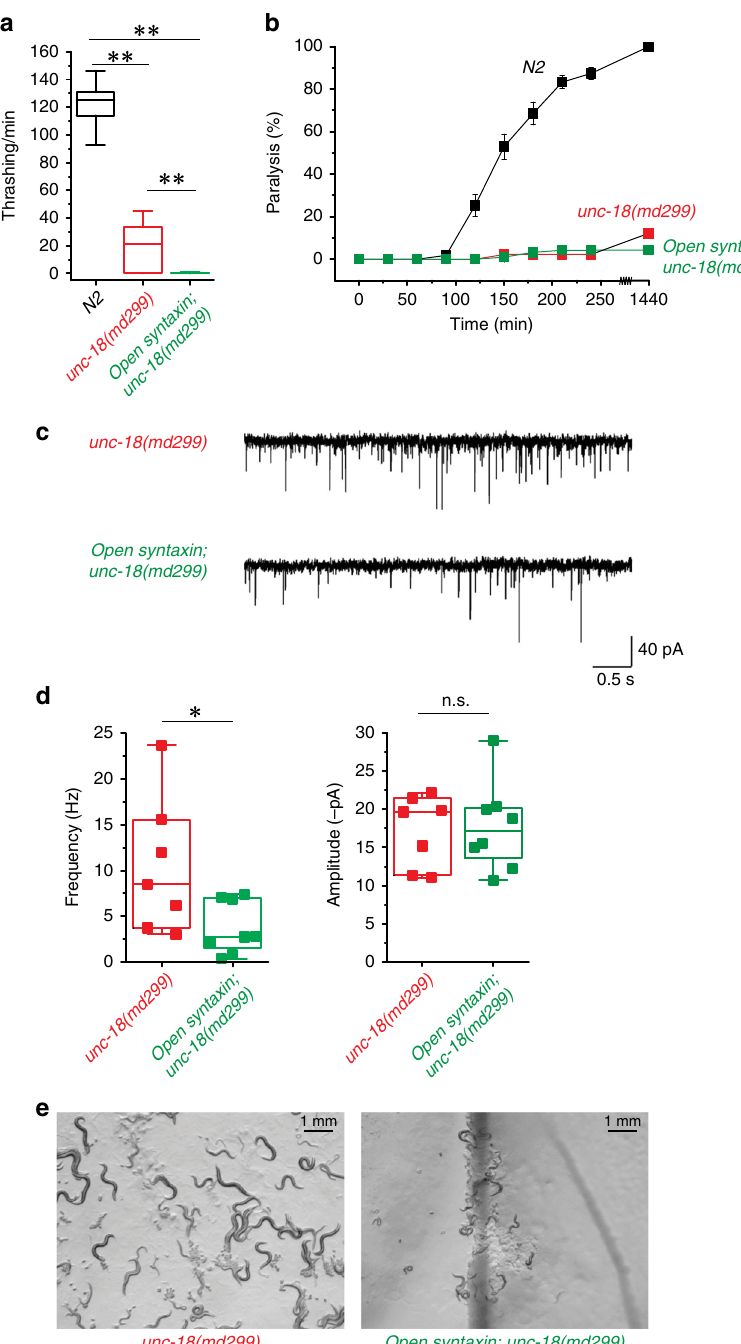
Fig. 7 Open syntaxin further impairs the unc-18 null phenotype. a Box-and-whisker plots of thrashing assay for N2, unc-18(md299) , and open syntaxin; unc- 18(md299) double mutants in M9 buffer. unc-18(md299) worms displayed greatly reduced thrashing rates (19.4 thrashes/min) which was reduced further by the introduction of open syntaxin in the double mutant to 0.610 thrashes/min. n = 41 for each strain. In one-way ANOVA statistical tests, F (2,120) =